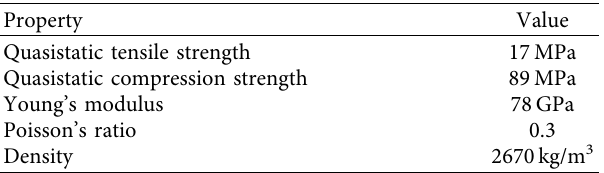
Table 4: Selected mechanical and physical properties of the Wulian granite